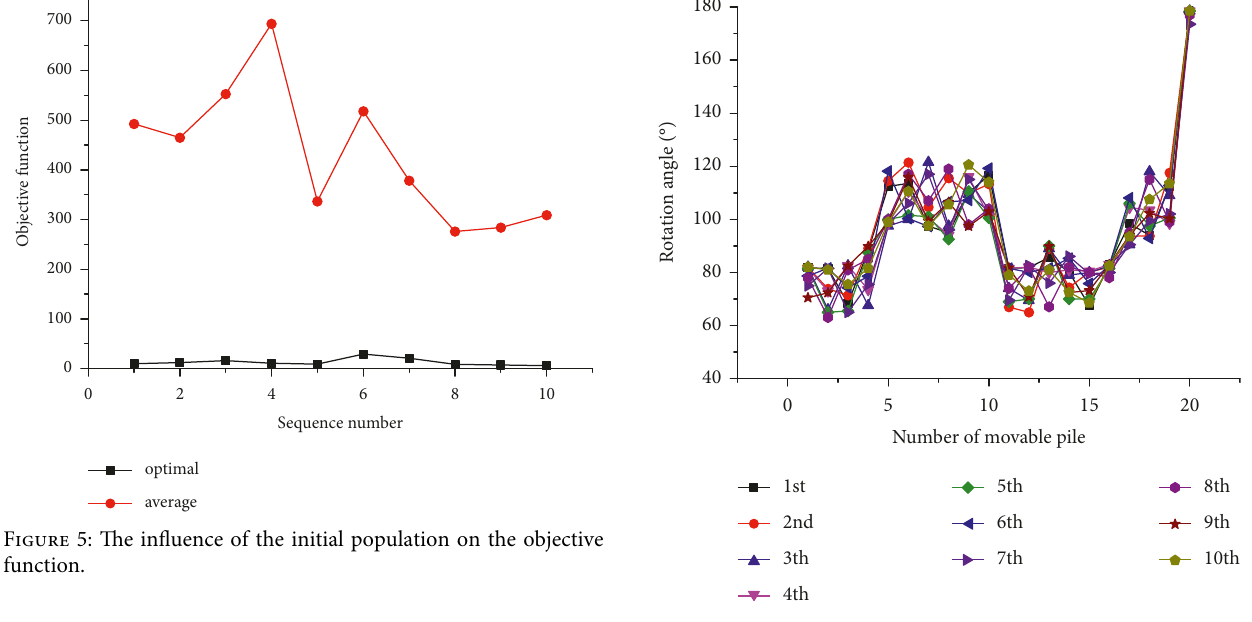
Figure 7: The influence of the initial population on the rotation angle.